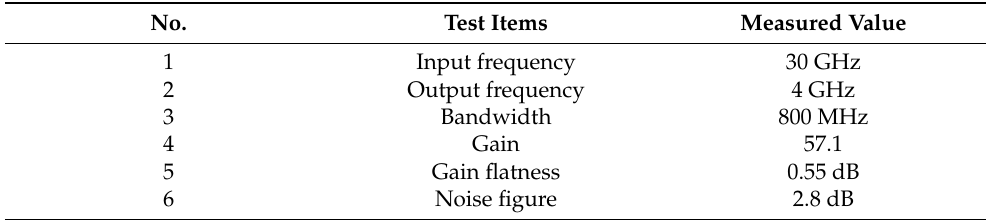
Table 7. Performance of the Ka band receiving SIP through the environmental compatibility tests.